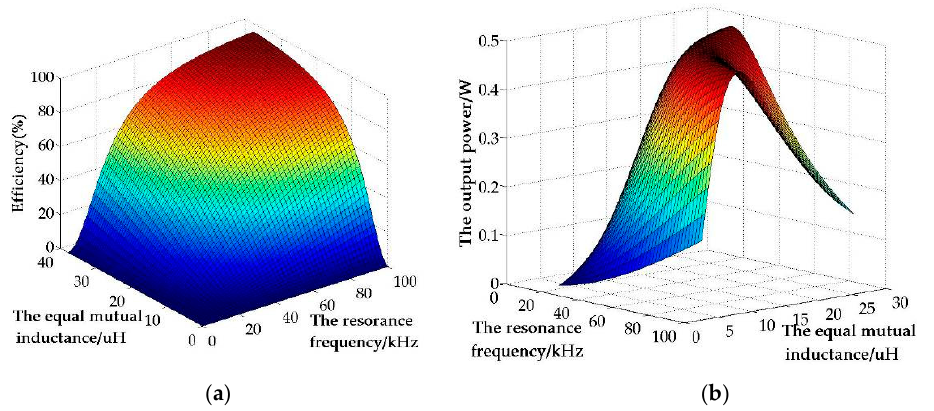
Figure 4. Transmission characteristics for WPT system: ( a ) the power transmission e ffi ciency changes with the resonance frequency and equivalent mutual inductance; ( b ) the output power changes with the resonance frequency and equivalent mutual inductance when U = 1